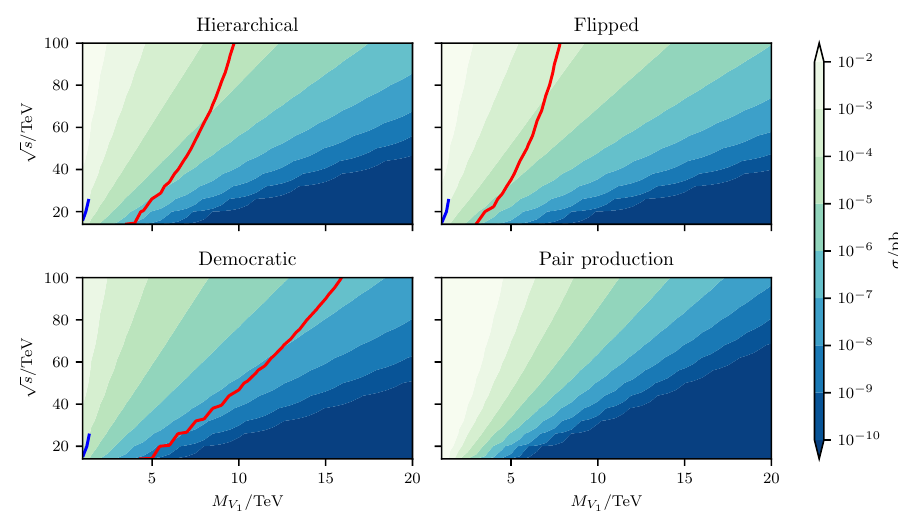
Figure 7 . Single leptoquark production cross section for V 1 depending on the center-of-mass energy √ s , and the leptoquark mass. For each scenario we use the central value of the allowed ranges from eqs. (2.10), (2.13). In the regions to the right of the red lines the single leptoquark production cross section is larger than the pair production cross section. In the regions to the right of the blue lines ∼ 10 TeV) the resonant leptoquark production cross section is larger than the single (up to M V 1 production one, see text. In the plot to the lower right we show in addition the pair production V − 2 / 3 cross section σ ( pp → V +2 / 3 ) . All plots are for κ = 0 1 1